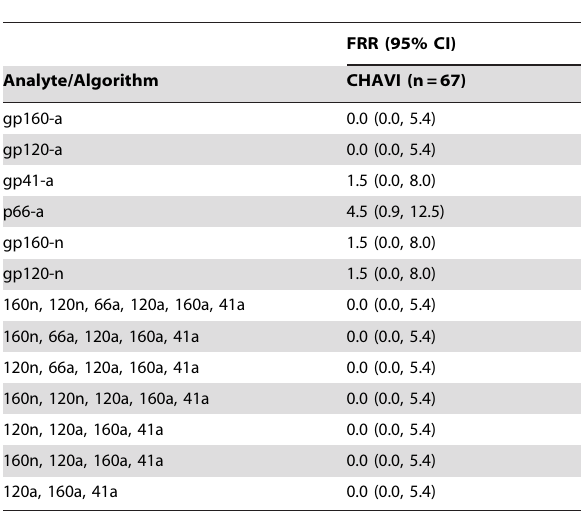
Table 3. Bio-Plex assay performance on subtype C